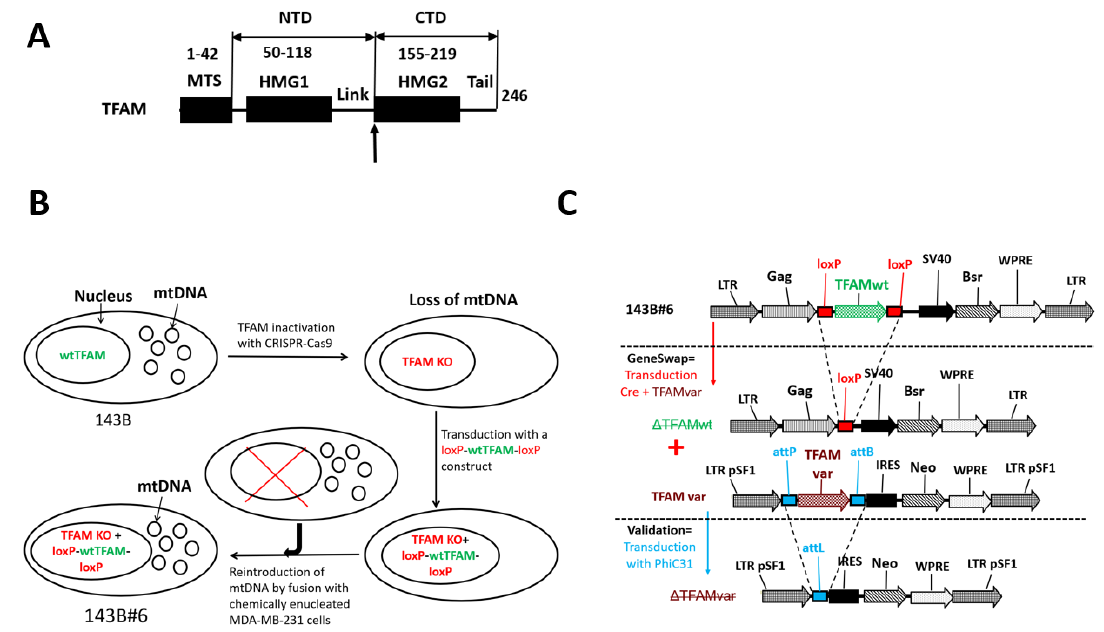
Figure 1. The domain organization of the human TFAM and GeneSwap approach. ( A ) The domain structure of human TFAM. The bold upward vertical arrow designates a crossover point in chimeras (between residues 154 and 155 of the hTFAM). Here, we refer to the TFAM portion preceding the crossover point as the N-terminal domain (NTD) and the following portion C-terminal domain (CTD). Subdomain boundaries are given in aa coordinates. MTS, matrix targeting sequence. ( B ) Derivation of the hTFAM GeneSwap cell line 143B#6. In 143B osteosarcoma cells, TFAM was inactivated with CRISPR/Cas9 and replaced with a retrovirus-encoded, loxP-site-flanked wt TFAM cDNA. To reintroduce mtDNA, the resulting cells were fused with chemically enucleated MDA-MB-231 cells, resulting in the 143B#6 cell line (9). ( C ) Schematics of the GeneSwap approach. To implement GeneSwap, 143B#6 cells (top panel) were co-transduced with retroviruses encoding Cre recombinase and altered TFAM (TFAMvar, central panel). This results in the excision of the wtTFAM cDNA and simultaneous re-expression of TFAMvar. In the resulting cotransductants, mtDNA is retained only if TFAMvar is functional in hmtDNA replication. In that case, the functionality is further validated by transducing cells with PhiC31 recombinase, which affects the loss of TFAMvar and hmtDNA (the bottom panel).